Question: Is the quantity shown trending increasing or decreasing?
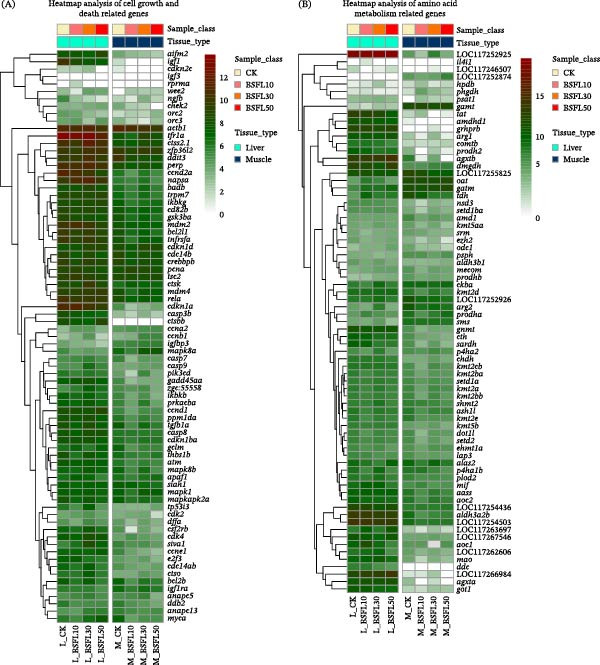
Answer: increasing